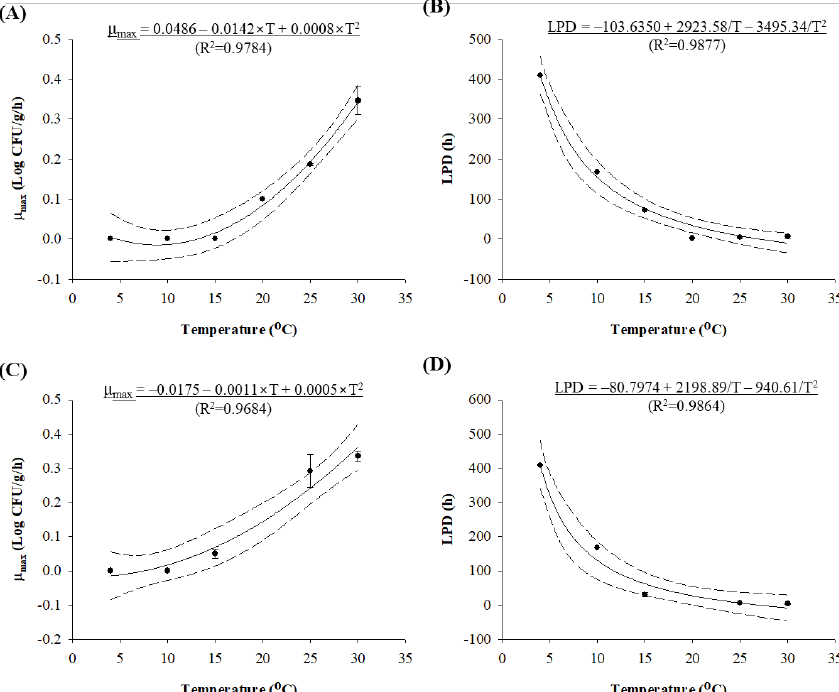
Figure 1. Secondary predictive model for the maximum specific growth rate (μ max ) and lag phase duration ( LPD ) of Salmonella spp. ( A , B ) and Staphylococcus aureus ( C , D ) in the cake as a function of temperature. Table 2. Kinetic parameters calculated by the Baranyi model for Salmonella spp. and Staphylococcus aureus growth in the cake. Bacteria Storage Temperature ( ◦ C)